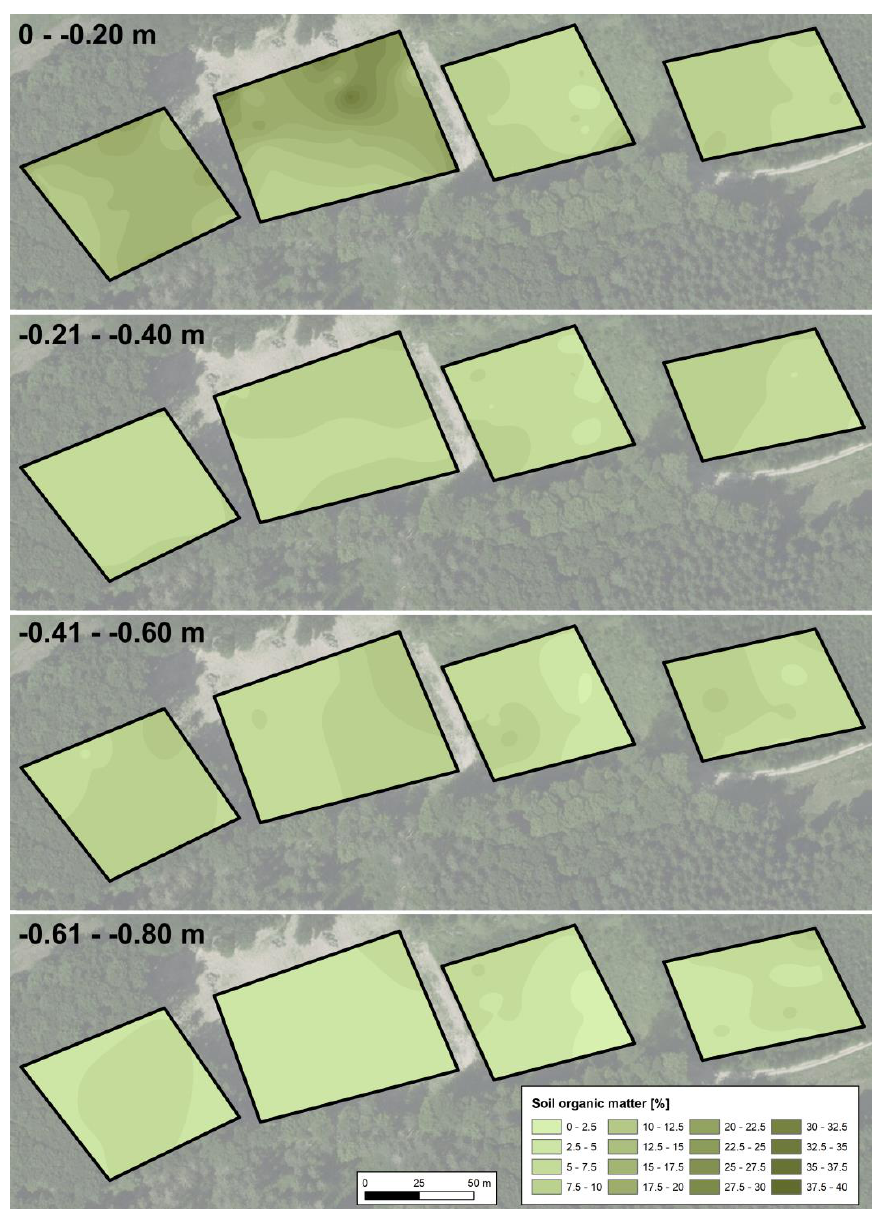
Figure 12. Interpolated soil organic matter, depth 0–−0.20 m. Aerial photography provided by LVermGeo RLP (2019). Table 10. Root mean square error (RMSE), interpolated raster soil organic matter.